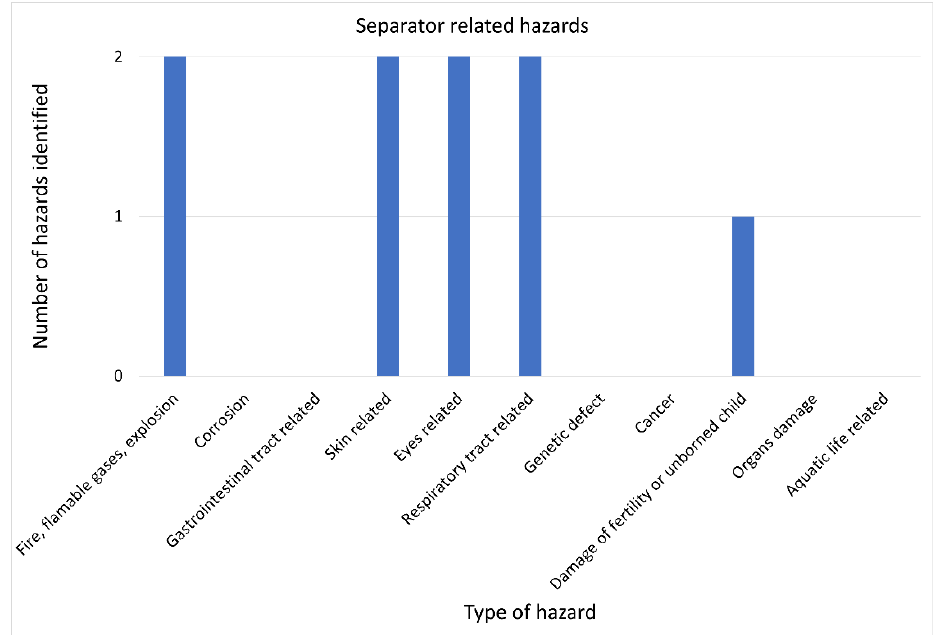
Figure 7. The number of the hazards identified versus the type of hazard for separator materials in Mg–S cells.